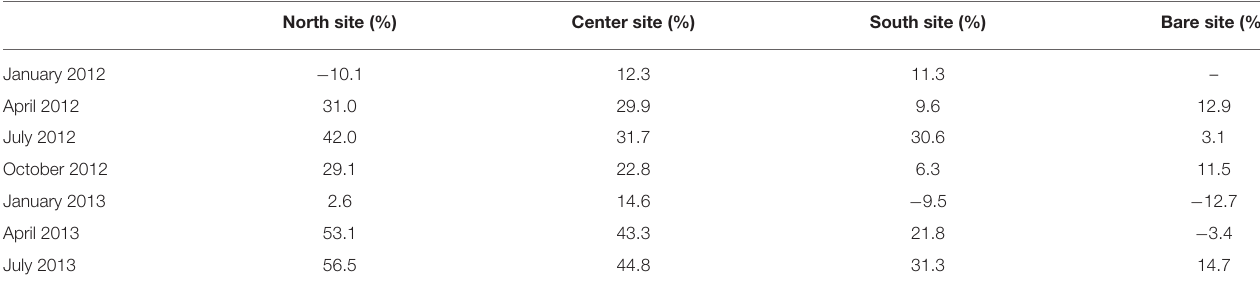
TABLE 3 | Percent difference between observed significant wave heights and significant wave heights predicted by the Young and Verhagen (1996) model at each site for southward blowing winds, averaged across each season. North site (%) Center site (%) South site (%) Bare site (%) 10.1 −